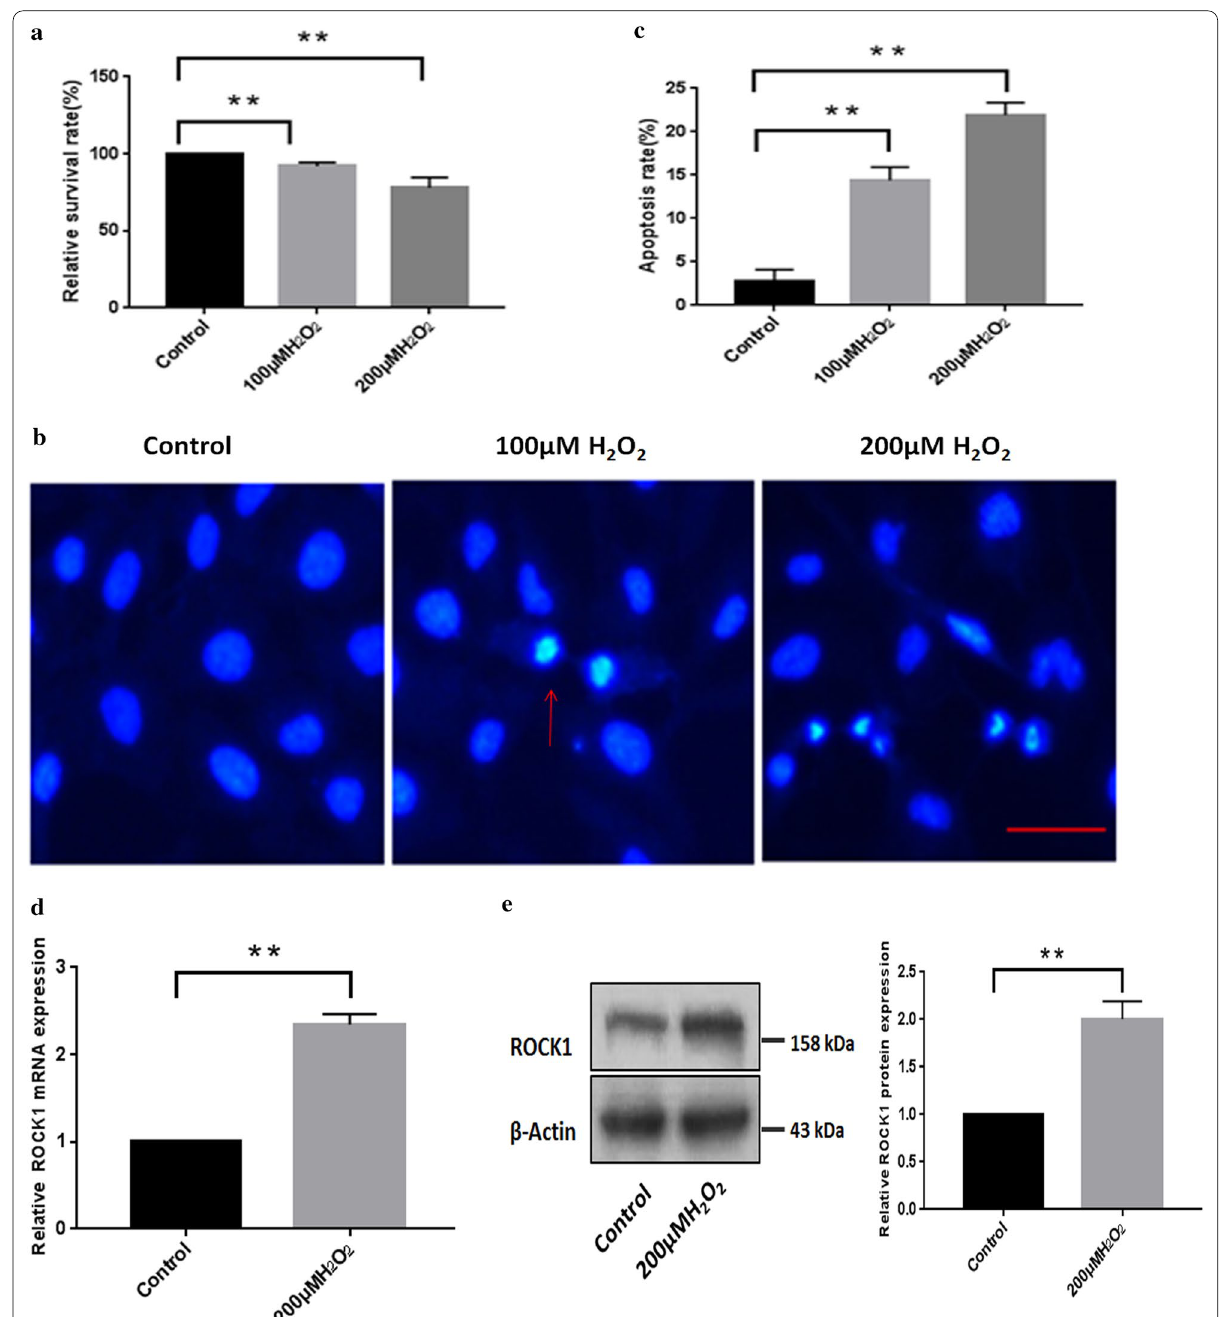
Fig. 4 Up-regulation of ROCK1 in apoptotic epithelial cells in response to H 2 O 2 . a H 2 O 2 inhibited the viability of LECs as measured by the MTT assays. B3 cells were incubated in the absence or presence of different doses of H 2 O 2 (100 and 200 µM) for 24 h, and cell viability was assessed by measuring absorbance at 492 nm with a microplate reader. **p < 0.01 versus the untreated cells. b The apoptosis detection of LECs under different doses of H 2 O 2 (100 and 200 µM) treatment for 24 h by Hoechst 33342 staining assay. The red arrow showed the nuclear morphology stained with blue by using Hoechst 33342. Scale bar: 50 µm. c Apoptosis rates were analyzed after treatment with different doses of H 2 O 2 (100 and 200 µM) treatment. The apoptosis rates, which were calculated based on at least 100 cells from three experiments, **p < 0.01 versus the untreated cells. d The mRNA expression of ROCK1 in B3 cells under 200 µM H 2 O 2 was assessed by quantitative RT-PCR. **p < 0.01 versus the untreated group. e The protein level of ROCK1 increased in lens epithelial cells under 200 µM H 2 O 2 treatment. The 100–250 kDa blot was retained by horizontal shear and incubated with the ROCK1 antibody. The 35–50 kDa blot was retained by horizontal shear and incubated with the β-actin